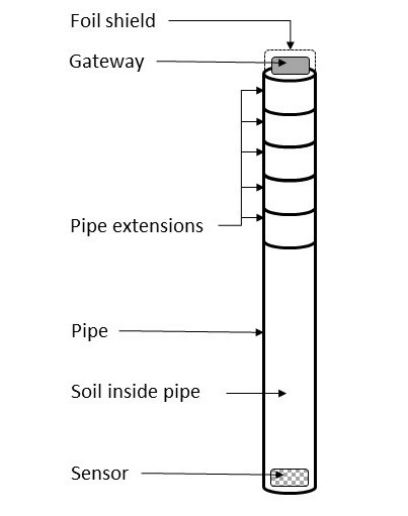
Figure 1. Experimental setup to evaluate the effects of variation in soil depth, moisture and type on signal strength (not to